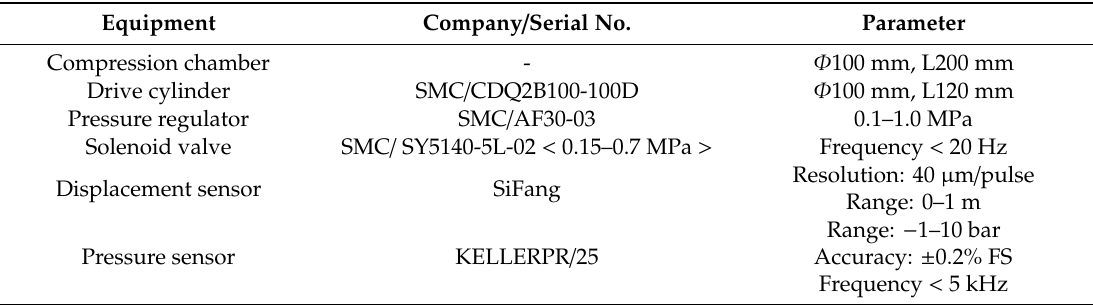
Table 1. Parameters of experimental equipment.